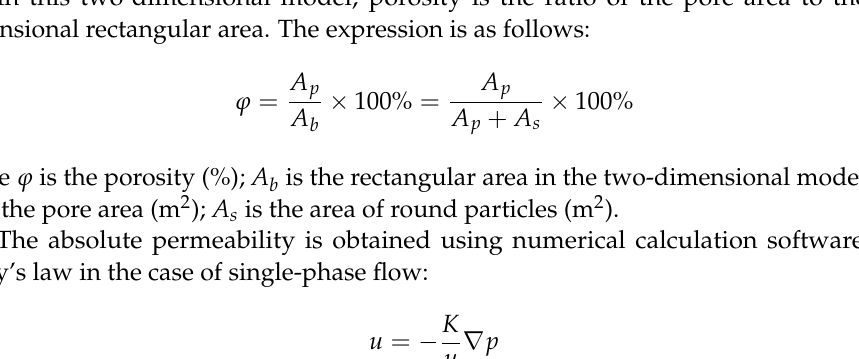
Figure 18. Schematic diagram of the 2D model with larger absolute permeability.